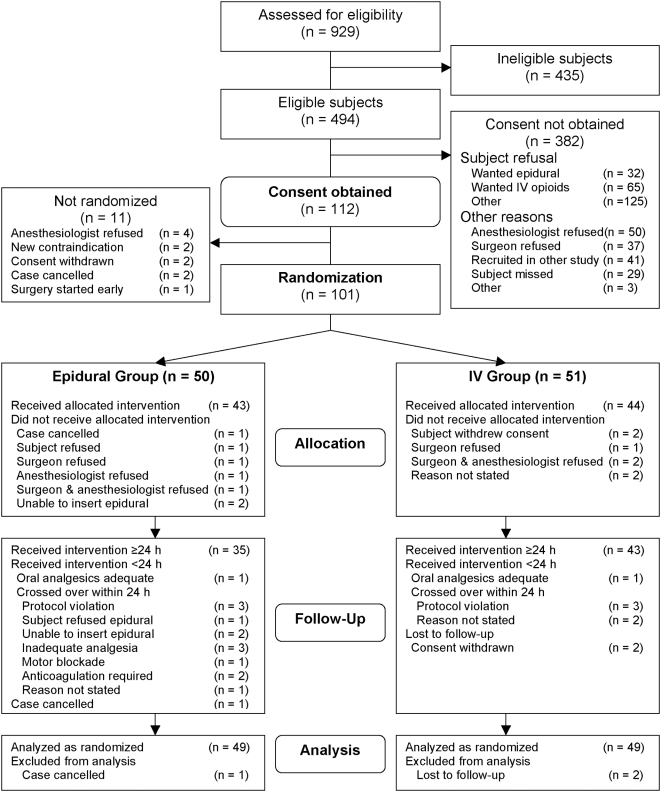
Flow of subjects through the PeriOperative Epidural Trial Pilot Study.